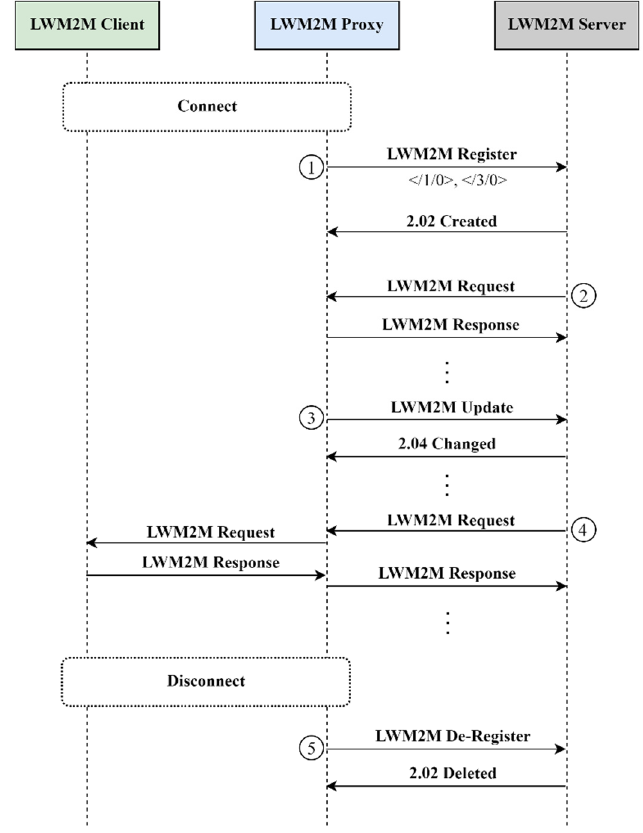
Figure 4. Optimized LWM2M.